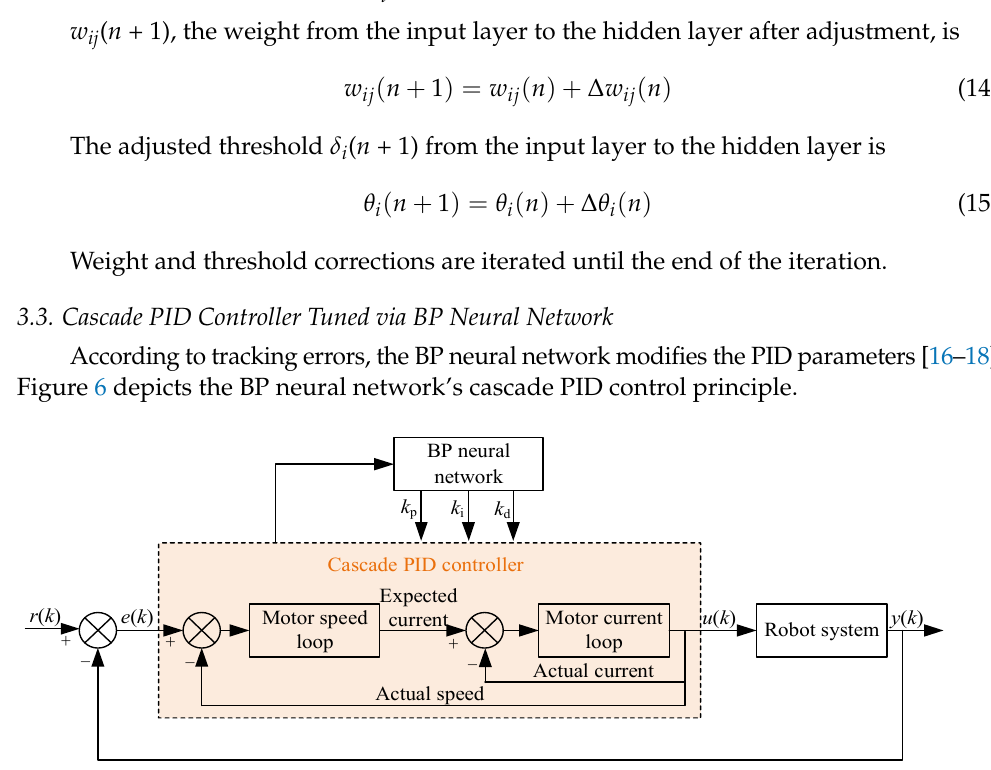
Figure 6. Cascade BPNN–PID controller.